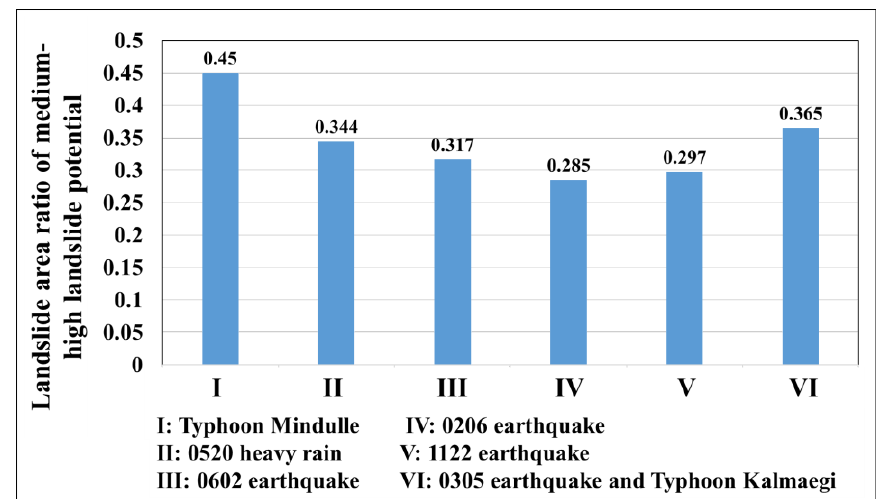
Figure 12. Landslide area ratio of medium–high-level landslides induced by rainfall and earthquakes in Alishan Township.